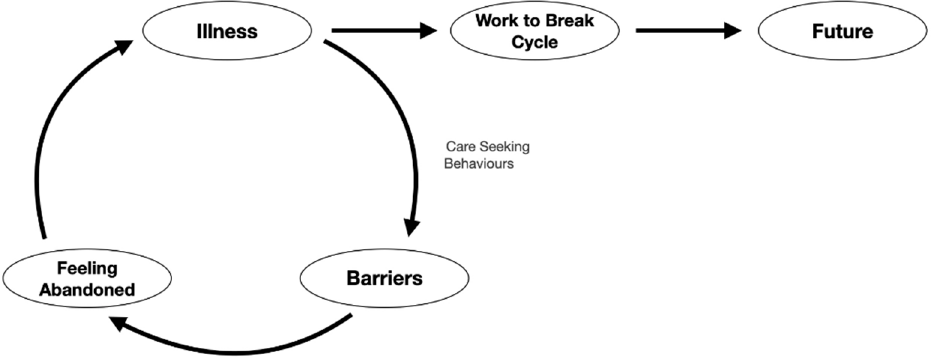
Figure 5. This image depicts the overall experience of participants by connecting the five central